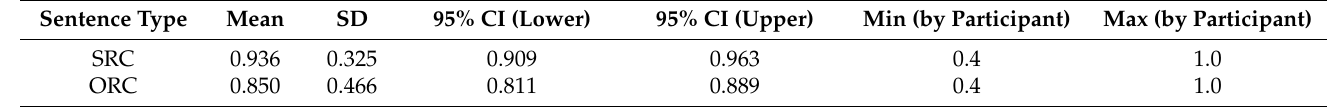
Table 4. Offline comprehension accuracy rate by sentence type.